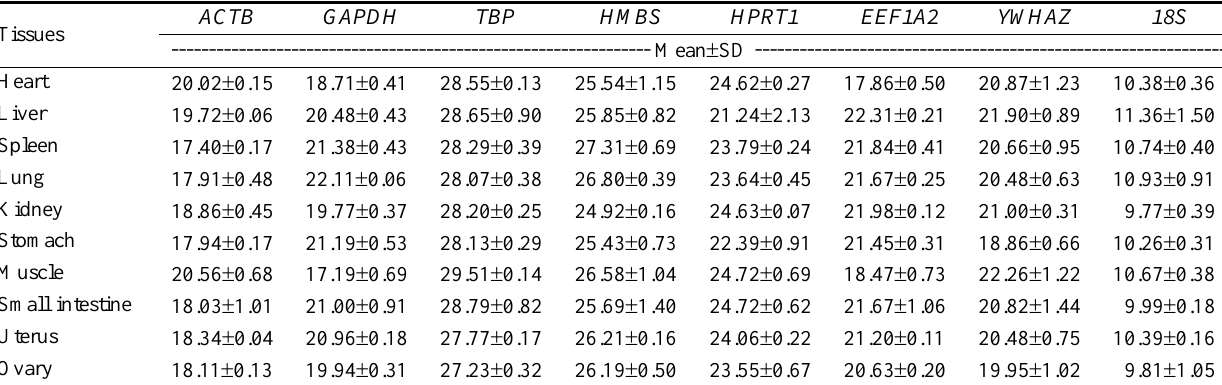
Table 2. Mean cycle threshold (Ct) values and standard deviation for candidate reference genes in examined tissues Tissues